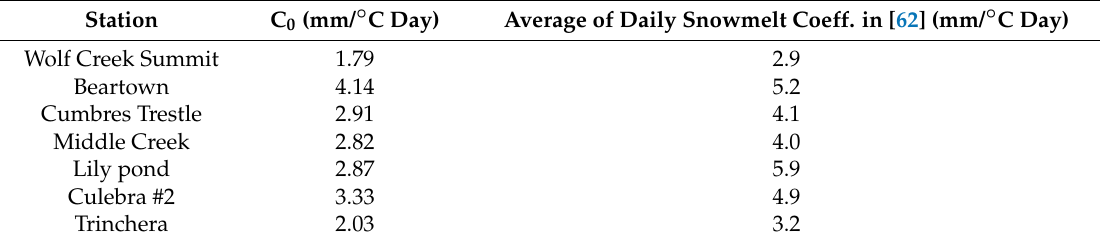
Table 1. SNOTEL stations used in the test, and snowmelt coefficients estimated with the proposed approach and in DeWalle et al.